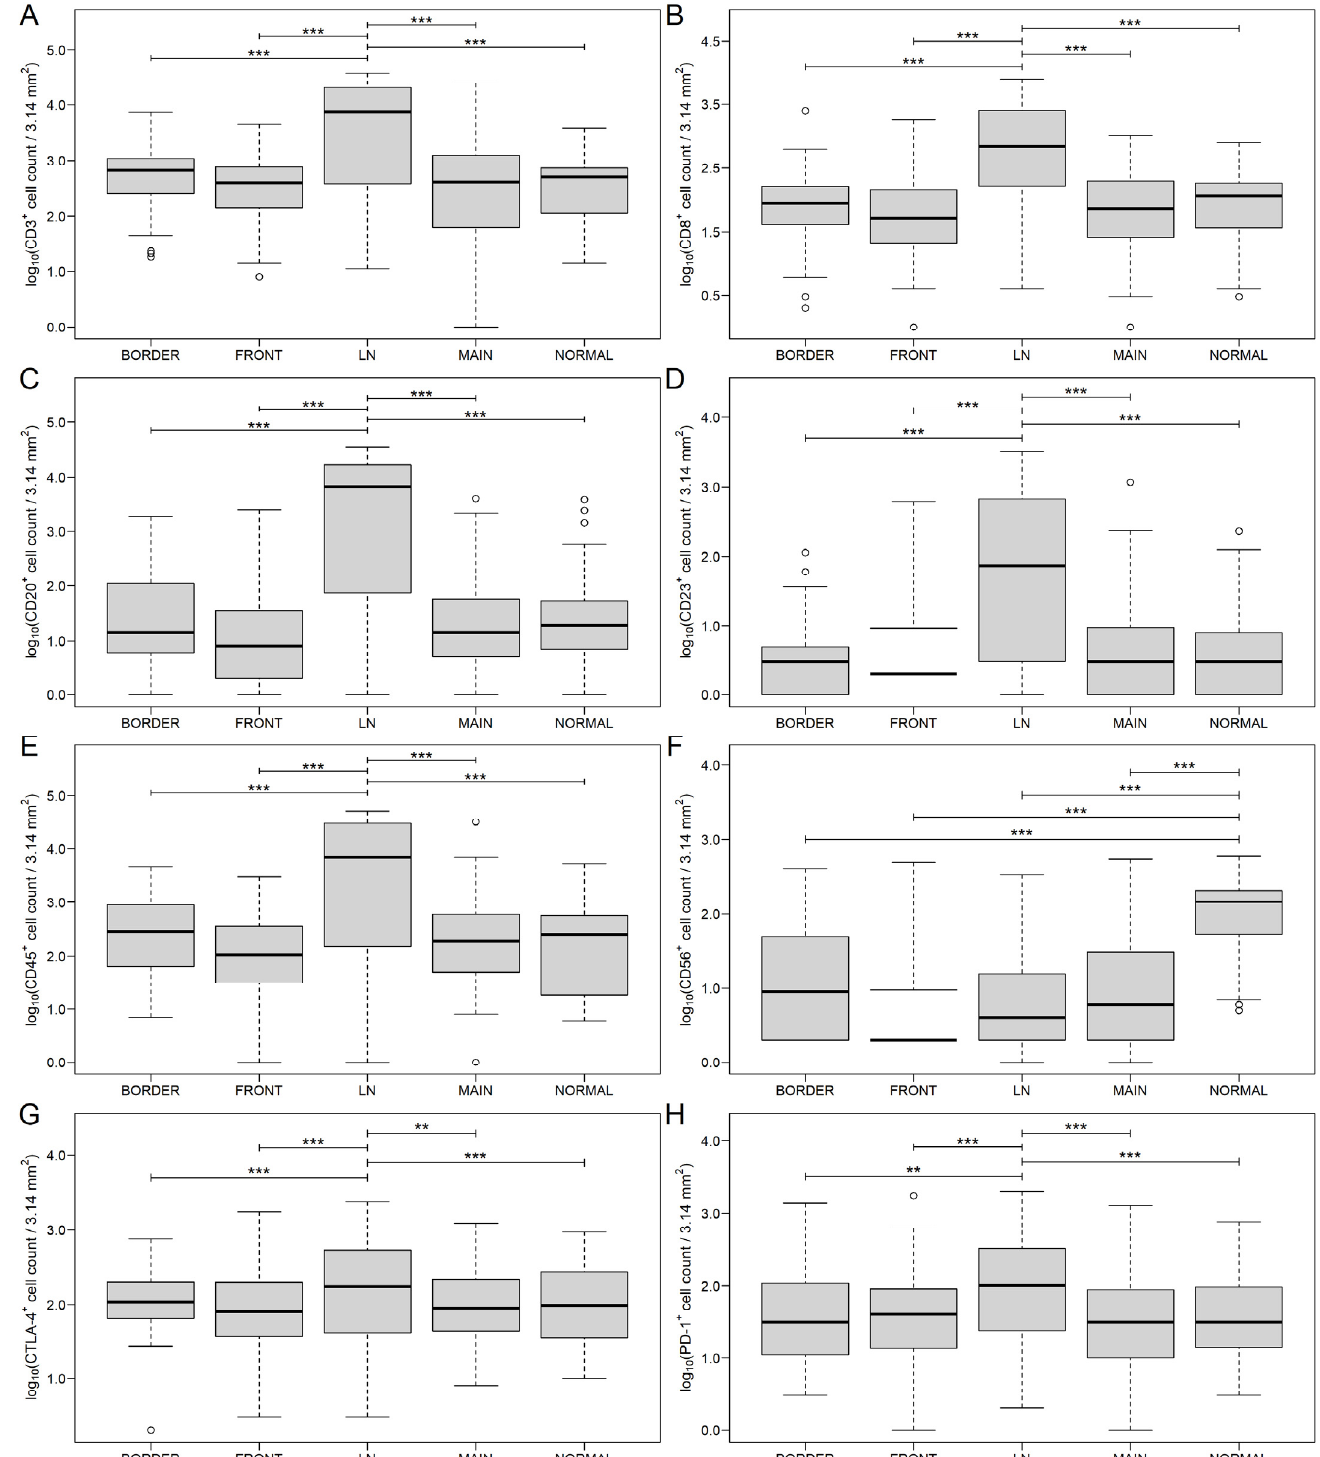
Figure 5. CD3 ( A ), CD8 ( B ), CD20 ( C ), CD23 ( D ), CD45 ( E ), CD56 ( F ), cytotoxic T ‐ lymphocyte ‐ associated protein 4 (CTLA ‐ 4, ( G )) and programmed cell death protein 1 (PD ‐ 1, ( H )) count data of colorectal cancer samples at different sites of the tumor. MAIN: main tumor mass; BORDER: tumor ‐ normal interface; FRONT: deepest infiltrative area; LN: lymph node metastasis; and NORMAL: normal colon tissue. The hollow black circles and the thick line represent outliers (>1.5 times the interquartile range above the upper quartile) and the median value, respectively. ** p < 0.01, *** p < 0.001.